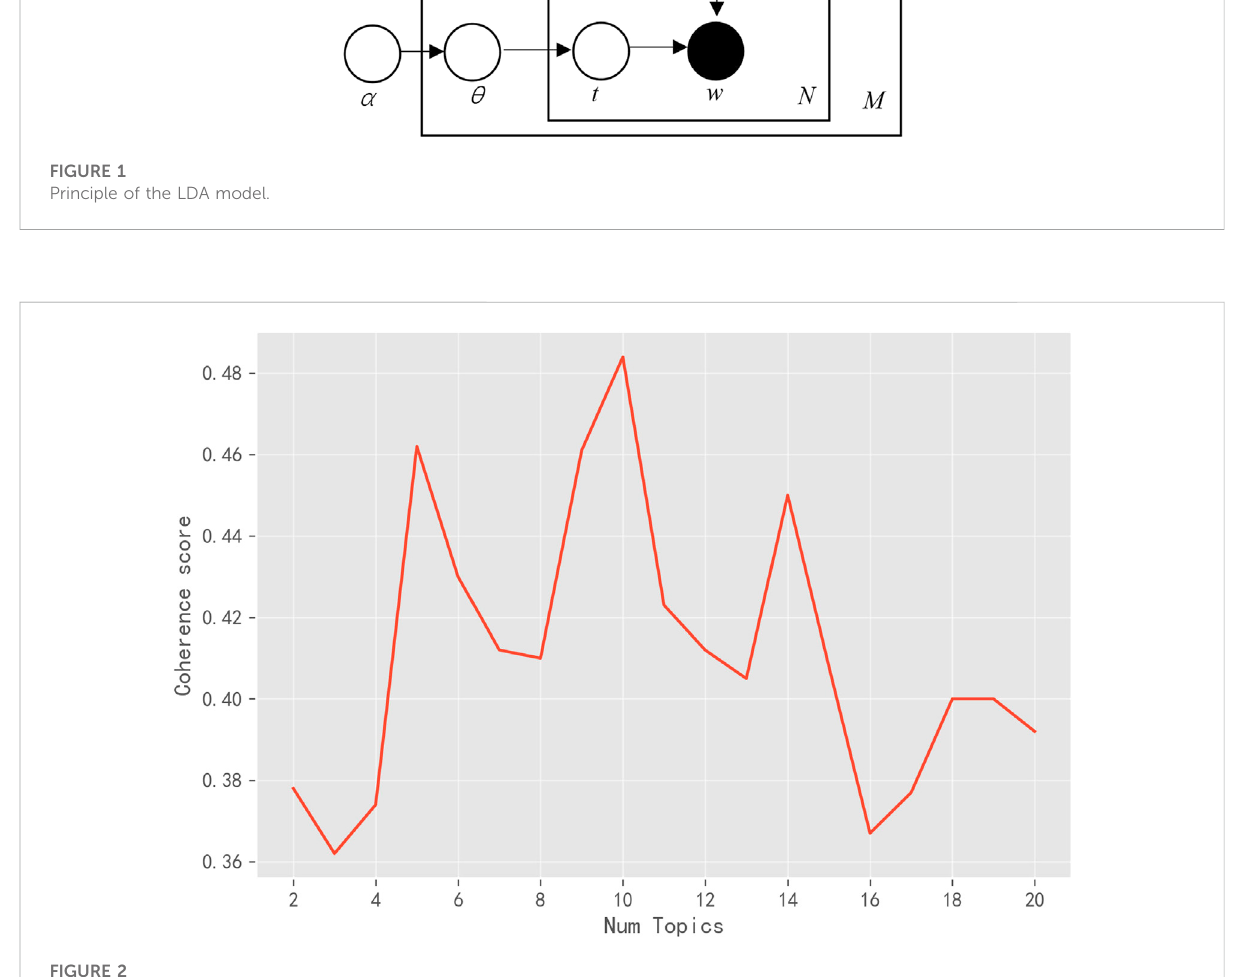
FIGURE 2 Topic consistency score.